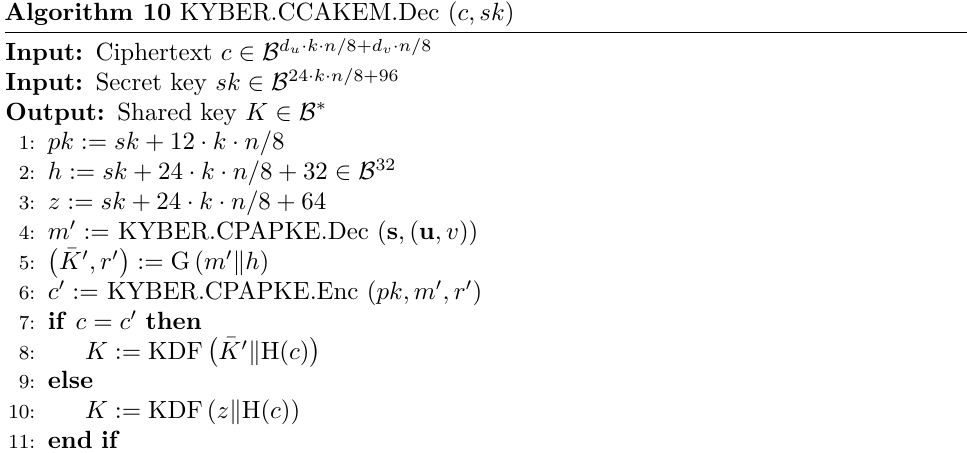
Algorithm 10 KYBER.CCAKEM.Dec ( c, sk